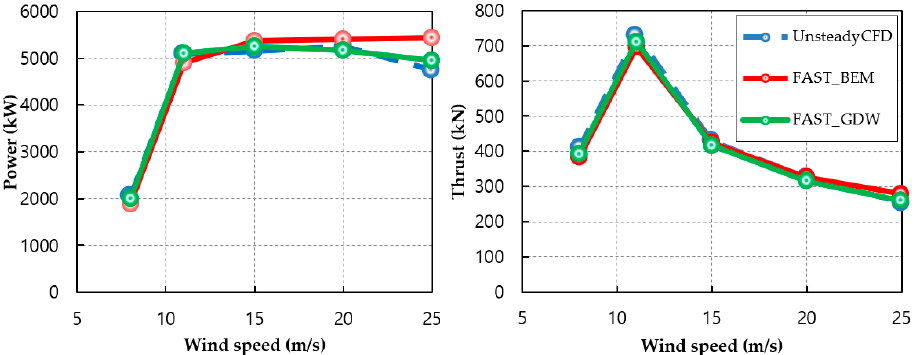
Figure 5. Power and thrust in 8, 11, 15, 20, and 25 m/s uniform wind speeds.